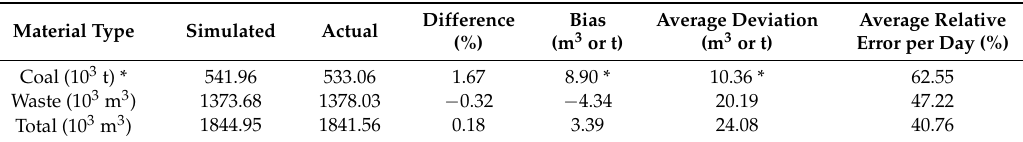
Table 6 . Summary statistics of simulated and actual production data of the case Profen, Exp. 2.